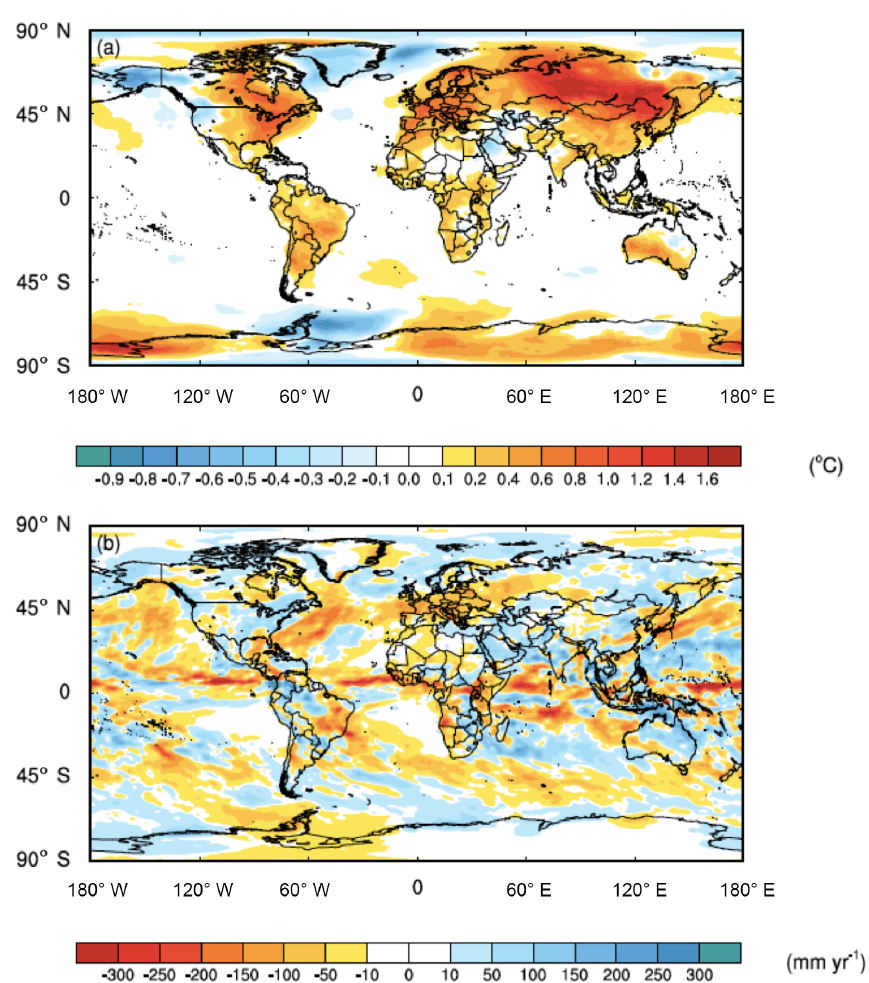
Figure 3. Feedbacks between symbiont-mediated N acquisition and C have a direct impact on global climate. (a) Surface air temperatures increase across much of the land surface, whereas (b) precipitation patterns are more variable. The values represent the mean differences for each grid cell between CAM-FUN with ramping CO 2 and the baseline CAM for the last 10 years of the simulations from 1995 to